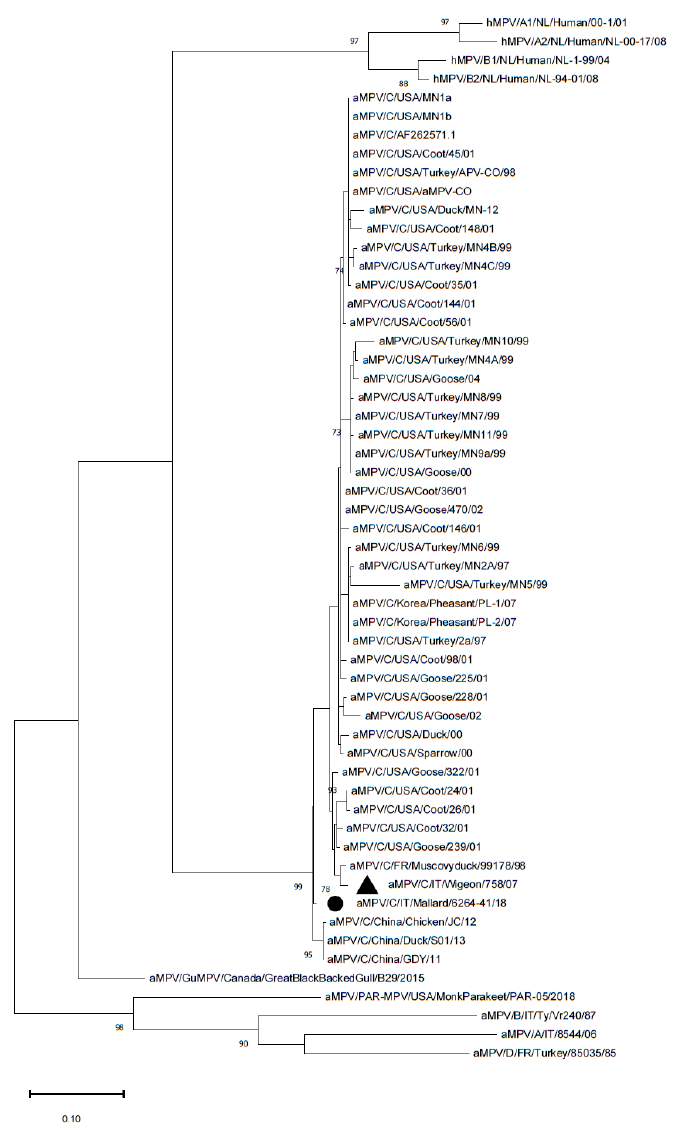
Figure 1. Phylogenetic tree reconstructed using the M gene of aMPV strains from Supplementary Table S1. The Italian mallard strain is marked with a black circle, whereas the previously detected Italian strain is marked with a black triangle. The tree was reconstructed using the Maximum Likelihood method and Tamura 3-parameter model with discrete Gamma distribution. Bootstrap support (>70%) is shown next to the branches. The tree is drawn to scale, with branch lengths measured in the number of substitutions per site. This analysis involved 56 nucleotide sequences. All of the positions containing gaps and missing data were eliminated. The final dataset was composed of 358